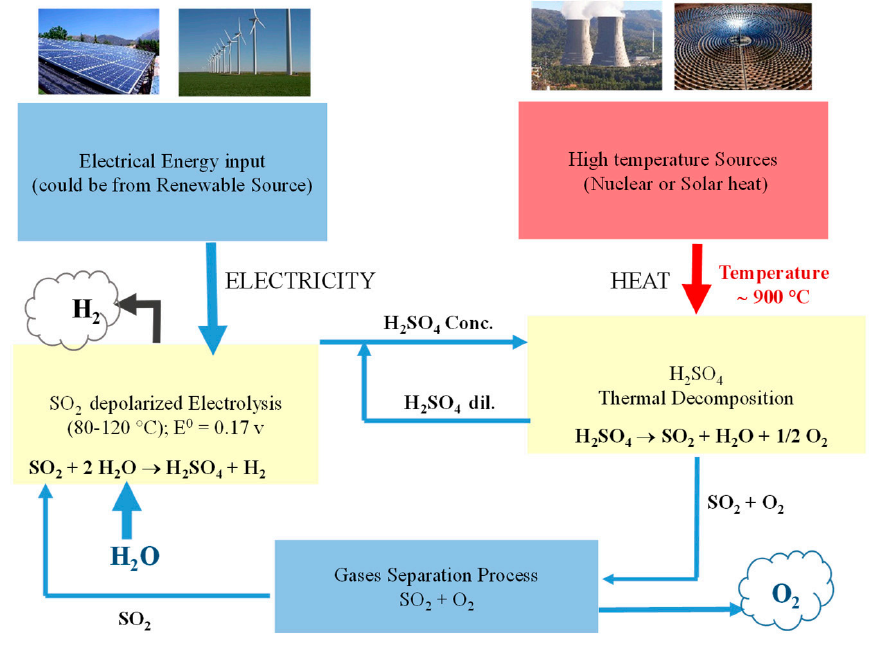
Figure 6. Hybrid Sulfur cycle [108].